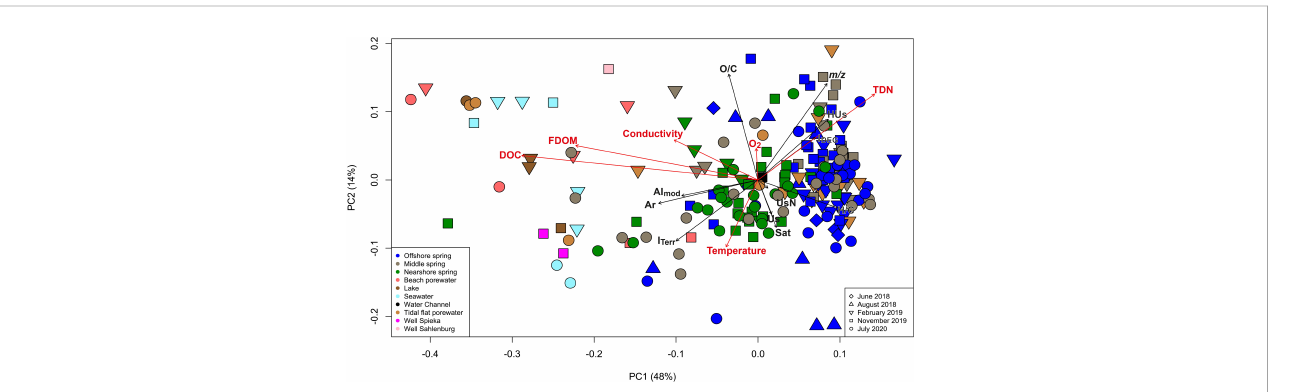
FIGURE 4 Principal coordinate analysis (PCoA) from all samples across the campaigns based on Bray-Curtis dissimilarities of the relative abundance of FT-ICR-MS derived molecular formulae data. The percentages give the DOM molecular variability as explained by the PC1 and PC2 axes. Correlations of coordinates to molecular characteristics and environmental parameters were considered signi fi cant with p ≤ 0.05. Colors represent the sample types and symbols represent sampling campaigns.